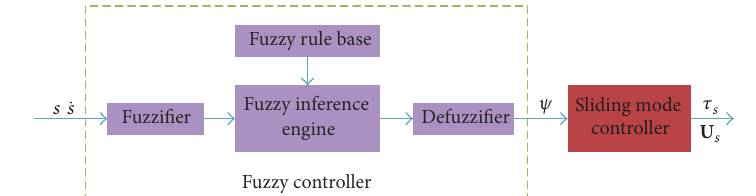
Figure 5: Adaptive fuzzy sliding mode controller.